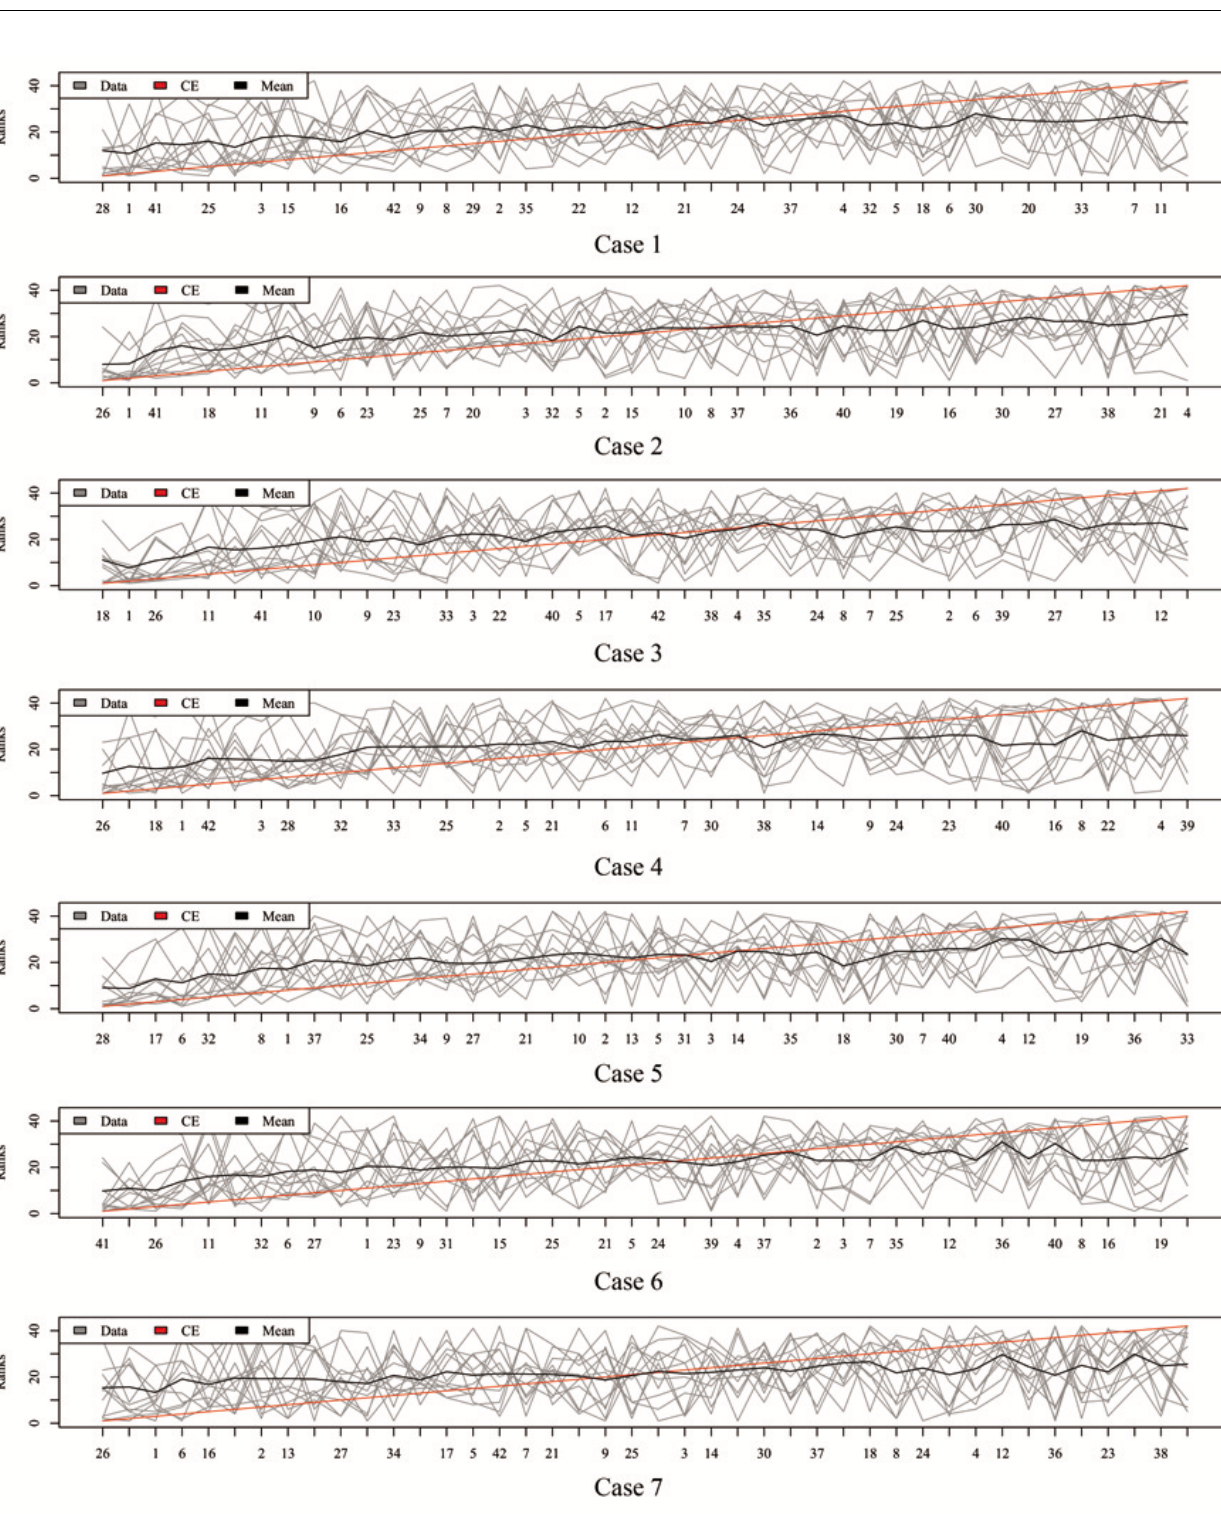
Figure 3. Rank lists of rank aggregation with the dataset “TBI” on seven